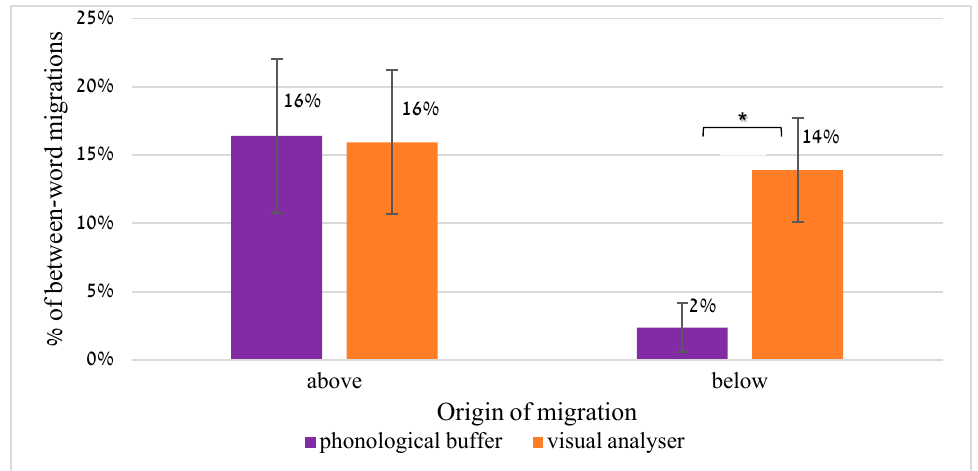
Figure 6. Origins of migrations between words out of all migrations between words: migrations originating in a word below or in a word above the target word. * p < 0.0001